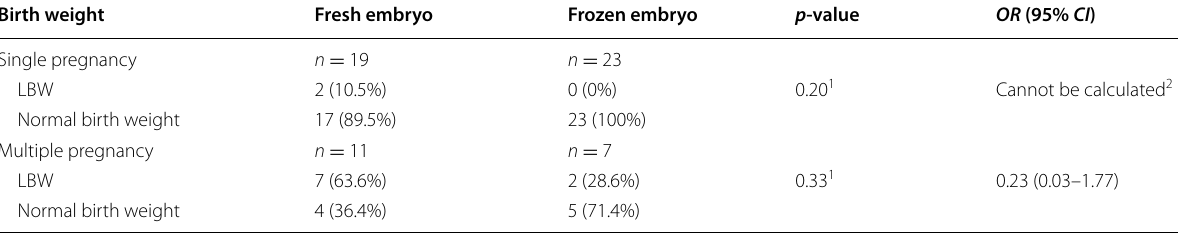
Table 3 Stratification analysis of relationship between LBW and embryo transfer types based on pregnancy